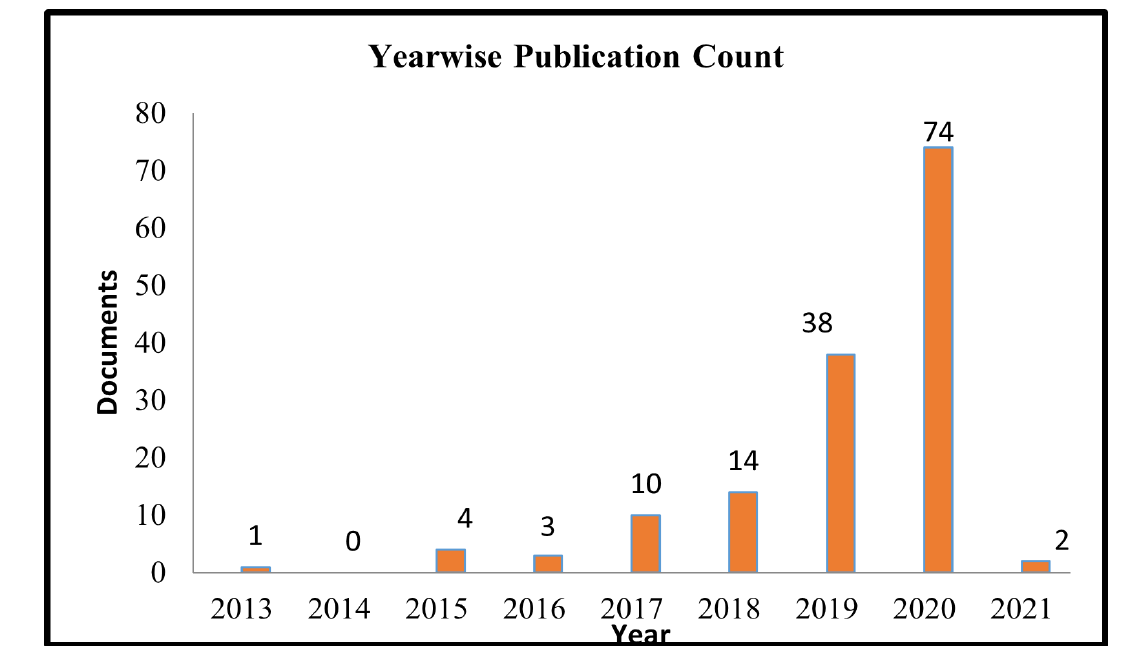
Figure 1. Yearly publishing trends of IoT in crop disease